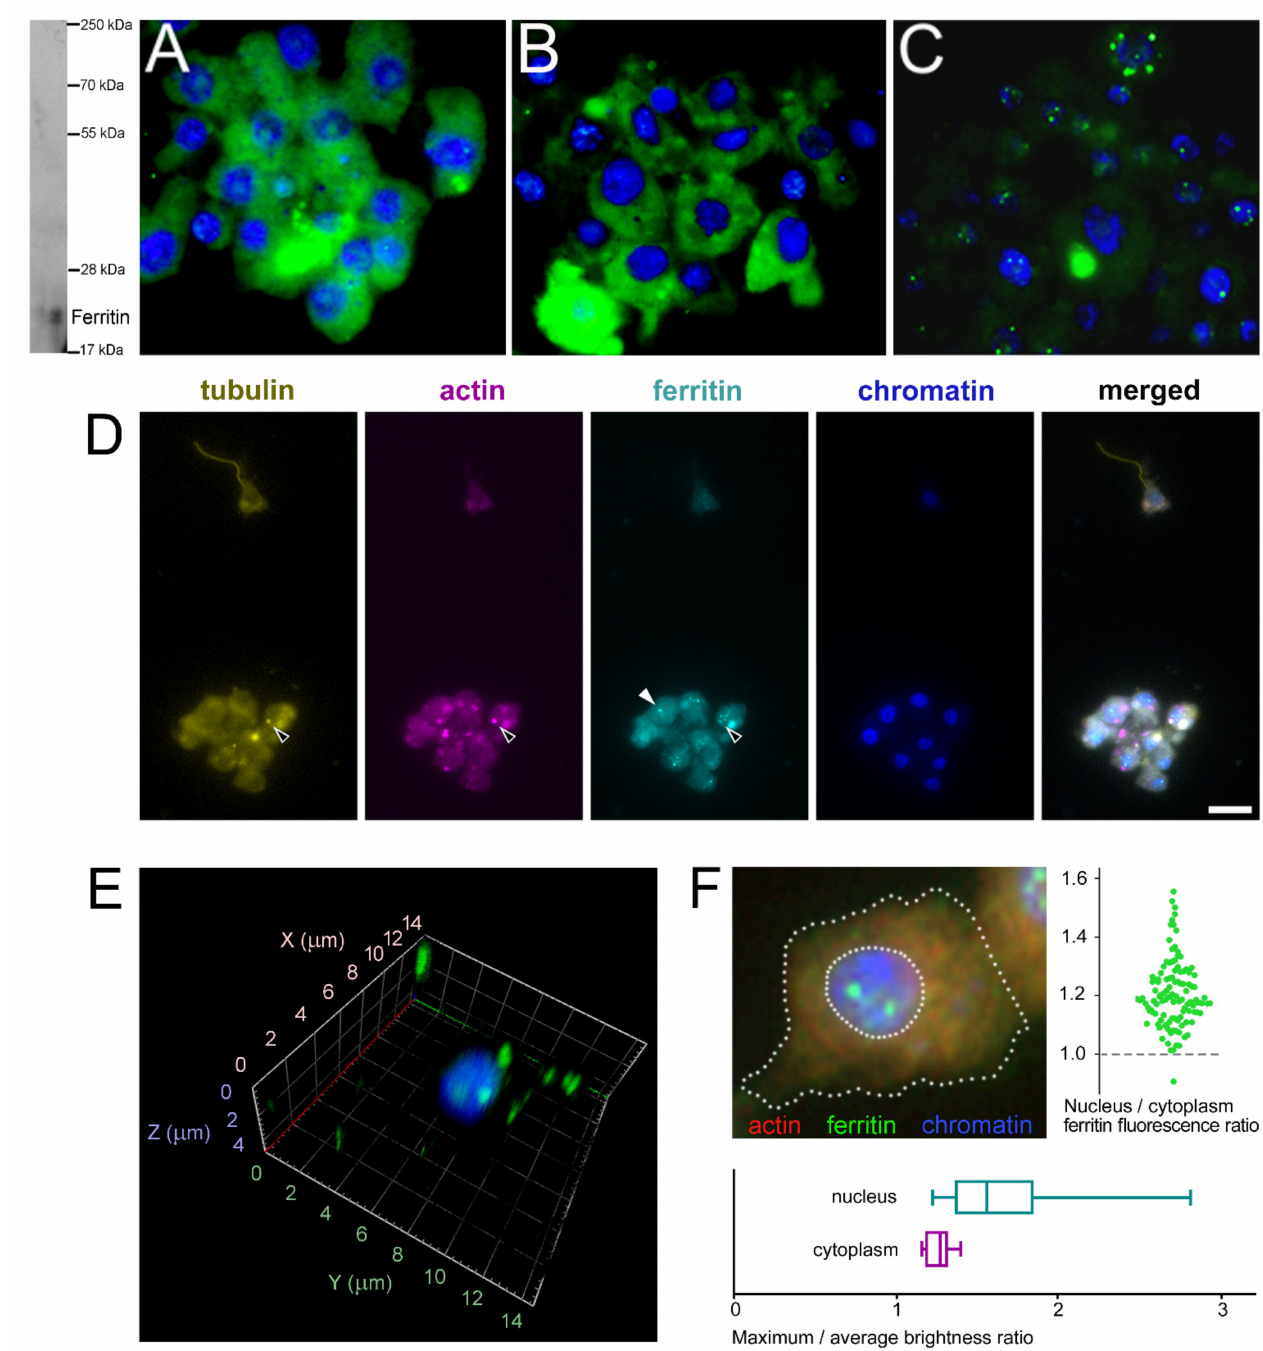
Figure 8. Subcellular localization of ferritin in H. dujardini cells. ( A – C ) Ferritin immune staining. Ferritin (green), Chromatin (blue). Western blot on the right shows the antibody specificity. Staining of cells collected at the end of sponge growth in Autumn ( A ), and at the beginning of sponge growth in Summer ( B , C ). The focal planes of maximum intensity presented. ( D ) Sponge cells, quadruple stained for tubulin, actin, ferritin and chromatin. Black arrows, cytoplasmic ferritin colocalized with both tubulin and actin; white arrow, cytoplasmic granule of ferritin without visible signs of colocalization with cytoskeletal proteins. Scale bar 10 µ m. Confocal microscopy of intranuclear ferritin in the isolated nuclei, 3D reconstruction. ( E ) Ferritin (green), Chromatin (blue). Intranuclear ferritin granules are co-purified together with nuclei. ( F ) Sponge cell, triple stained for actin, chromatin and ferritin (dashed lines denote boundaries of the cell and the nucleus). Swarmplot shows the ratio of average fluorescence levels between ferritin localized in the nucleus and in the cytoplasm of each cell, N = 114. Boxplot compares the ratio of the maximum to the average fluorescence level of ferritin localized in the nucleus and in the cytoplasm of each cell, N =